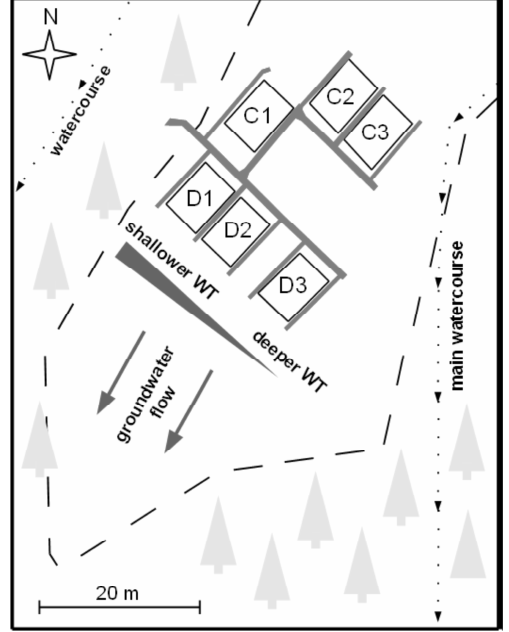
Fig. 1. Sketch of the fen site. Six experimental plots, each 7 × 5m, were designed and accessed using wooden platforms. Water table was manipulated (drying/rewetting in 2008 and flooding in 2009) in plots D1, D2 and D3. No manipulation took place in plots C1, C2 and C3. Water from the main watercourse was used to irrigate D plots during the flooding. Note that D plots had deeper mean WT compared to C plots in addition to the lateral water table (WT) gra- dient. Peat properties also differed among plots (refer to Table 1; Estop-Aragon´es et al., 2012). Copyright 2012 American Geophys- ical Union. Reproduced by permission of American Geophysical